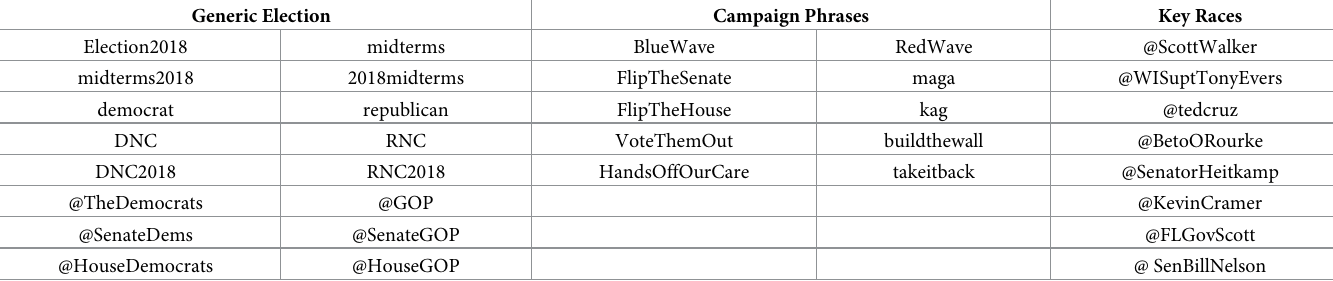
Table 1. Election-related keywords submitted to capture relevant tweets associated with the 2018 U.S. midterm elections via the Twitter API. Generic